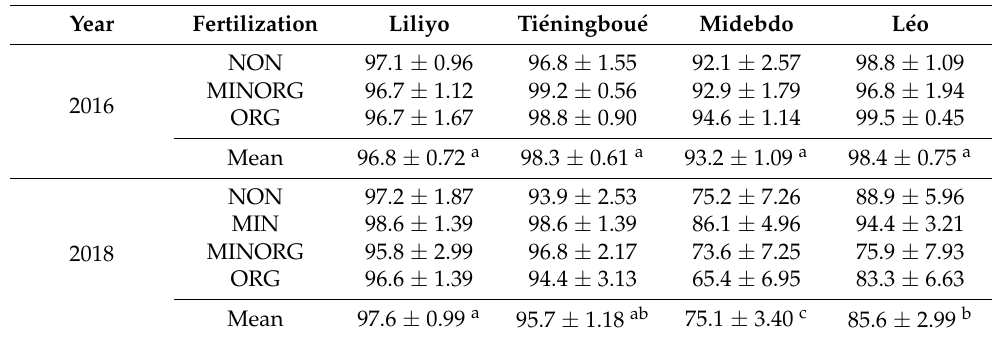
Table 3. Cumulative rate of water yam sprout emergence at 49 DAP, according to fertilization regimes in Liliyo and Ti é ningbou é (C ô te d’Ivoire), and Midebdo and L é o (Burkina Faso), in 2016 and 2018. In 2018, yam variety C18 was cultivated in the four sites, after either a cereal, a legume, or a yam for each fertilization